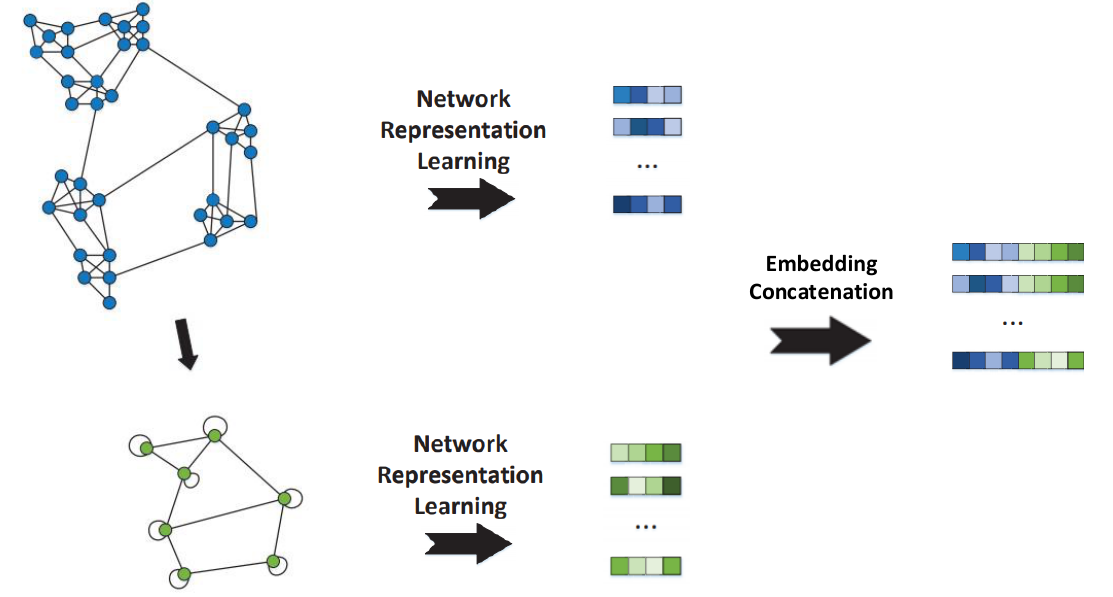
Figure 5. The process of the SF-NRL algorithm.